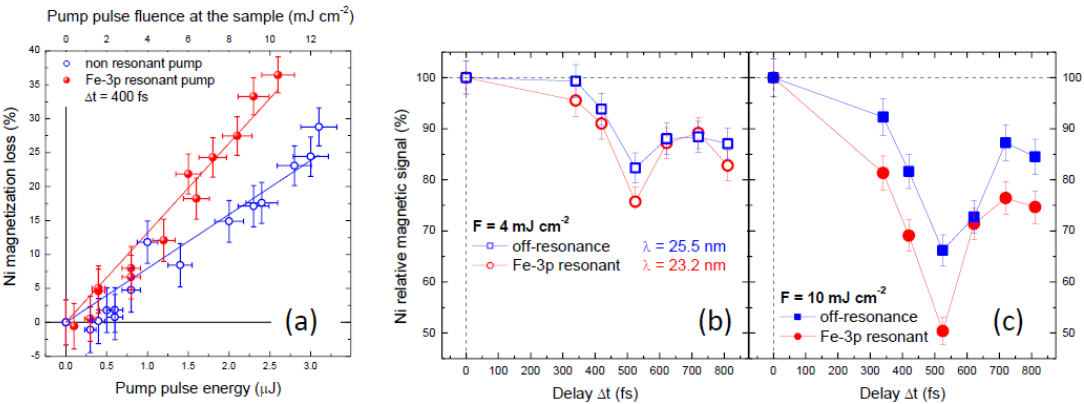
Figure 7. Ni magnetic response in Ni-ferrite. ( a ) Relative Ni magnetization loss as a function of F for Fe-3p resonant and non-resonant pumping, at a fixed delay of 400 fs; ( b , c ) Normalized Ni magnetization as a function of delay Δ t for resonant and non-resonant pumping at F = 4 mJ·cm −2 ( b ) and F = 10 mJ·cm −2 ( c ). Error bars on Δ t (±5 fs) are smaller than the symbol size.